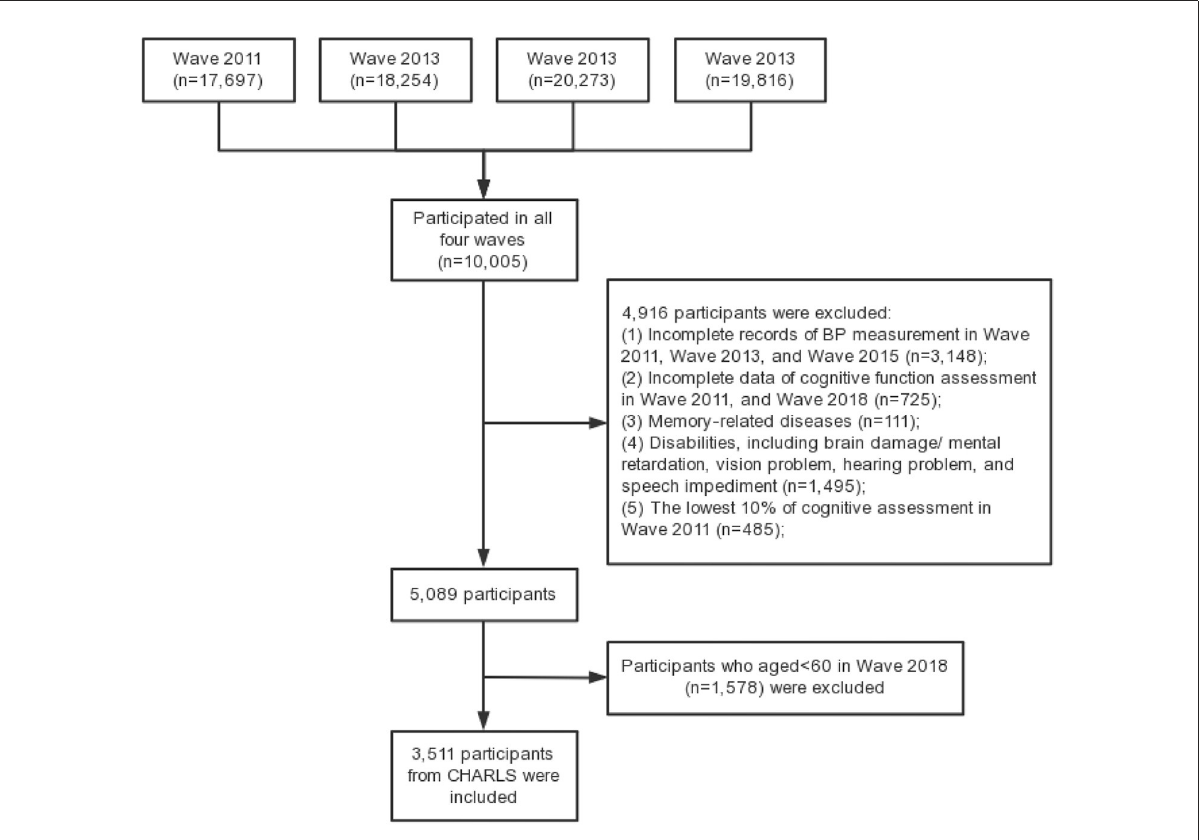
FIGURE1 Flow chart for the sample selection.